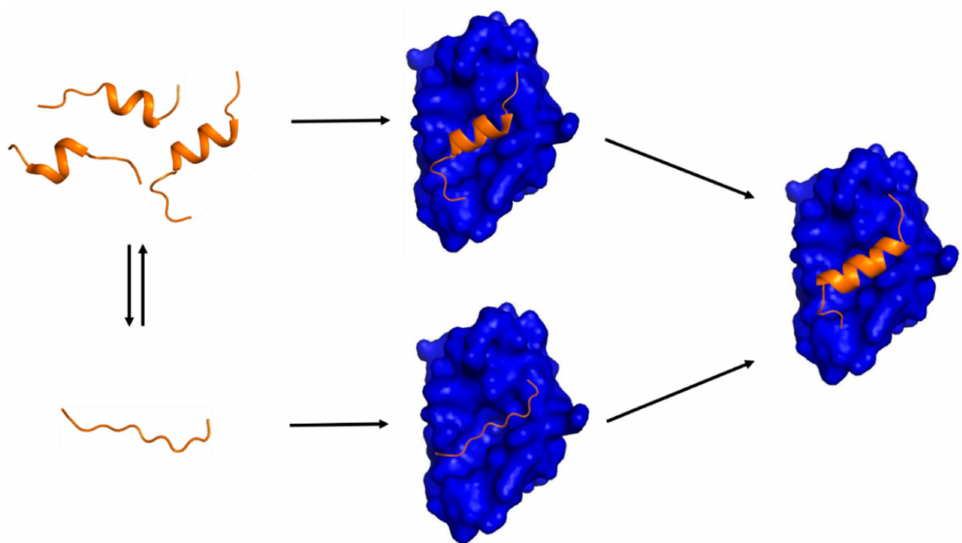
Figure 1. A schematic diagram showing two possible mechanisms of IDP-target binding. ( Left ) a target-free fragment of an IDP or a long (> 40 residues) IDR exists in a conformational ensemble where a completely unstructured state (bottom) is in equilibrium with a pre-populated state having transient helices of slightly different helical lengths (top). The fraction of the pre-populated state has been shown to vary from one IDP to another (10 ~70%) [5]. The three pre-structured helices with slightly different helical lengths were experimentally observed by Flexible-Meccano calculations using residual dipolar couplings in the case of the N TAIL of Sendai virus nucleoprotein [31] and 4EBP1